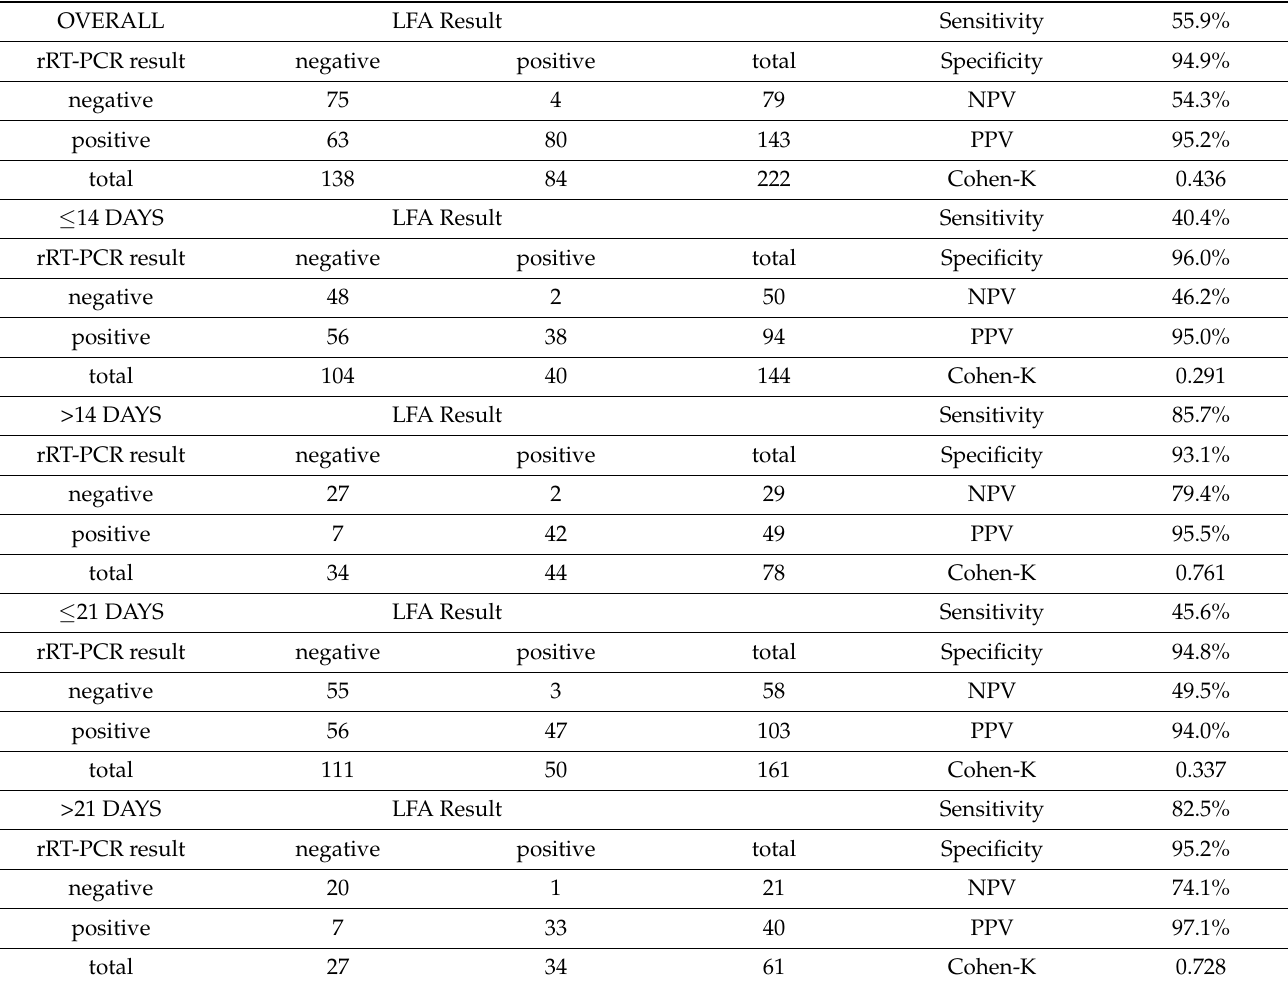
Table 1. Analytical performance of LFA, compared with the ‘gold standard’ biomolecular testing as a reference. The performance has been evaluated relative to the time of